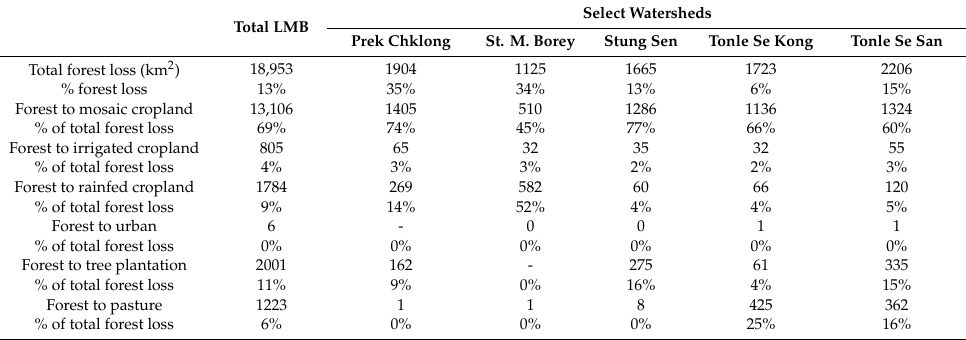
Figure 5. 2001 land cover map (this paper) with subsequent forest loss between 2001–2013 from Hansen et al. (2013) [27]. Key watersheds are identified. Table 2. Areas and percentages of forest loss and major drivers for select watersheds in the LMB.